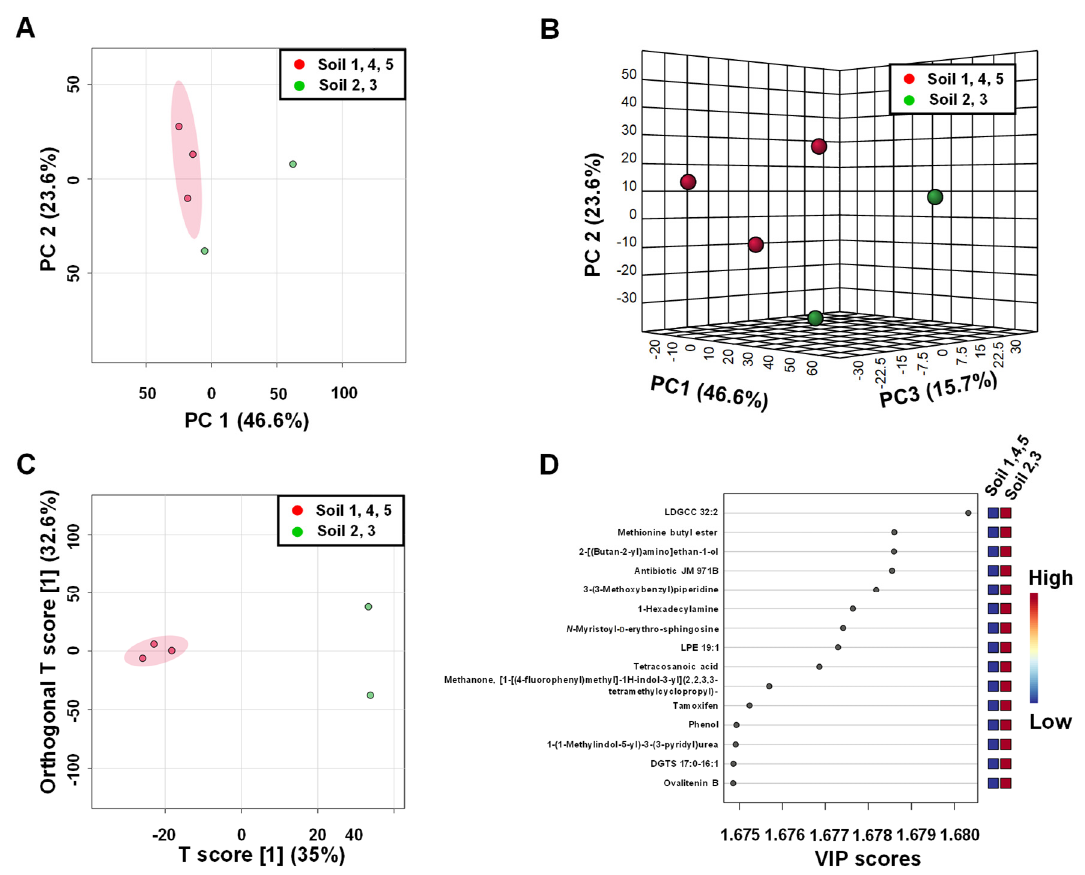
Figure 13. Analysis of soil profiles created for LC-MS data. ( A ) 2D PCA; ( B ) 3D PCA; ( C ) OPLS-DA scores plots generated from the LC MS data of the soil 2, 4 and 5 (red) and soil 2 and 3 (green) samples; ( D ) Metabolite ranking for OPLS-DA model according to VIP scores.